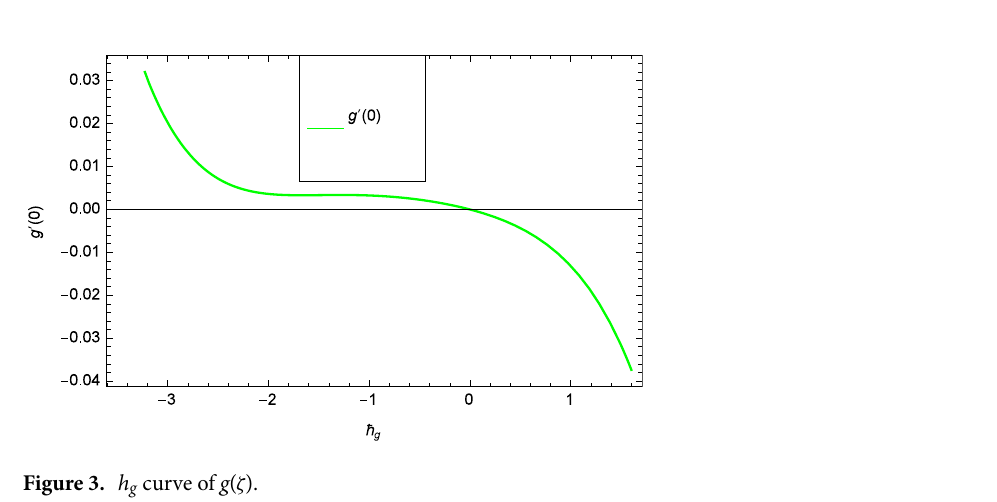
Figure 3. h g curve of g ( ζ